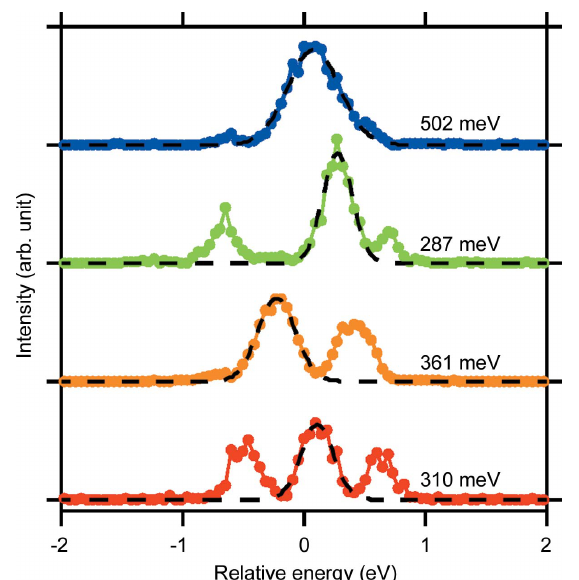
Figure 4 Typical single-shot spectra of incident XFEL pulses after the Si(111) double-crystal monochromator measured with a high-resolution disper- sive spectrometer (Inubushi et al. , 2012; Katayama et al. , 2016) using an Si(660) flat crystal analyser. The energy resolution is approximately 50 meV. Each dashed line represents the fitted Gauss function, for which the FWHM is indicated. The number of longitudinal modes before the monochromator was approximately 60 (Inubushi et al. ,